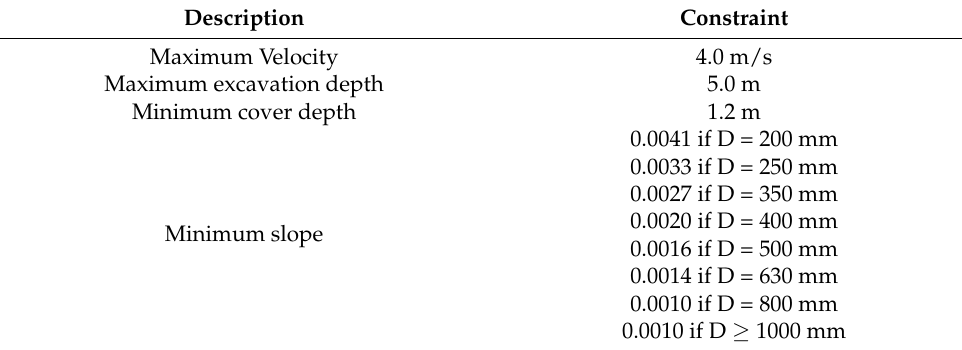
Figure 3. Case study base graph of a section from the city of Ahvaz, Iran [46]. Table 1. Design constraints for the case study